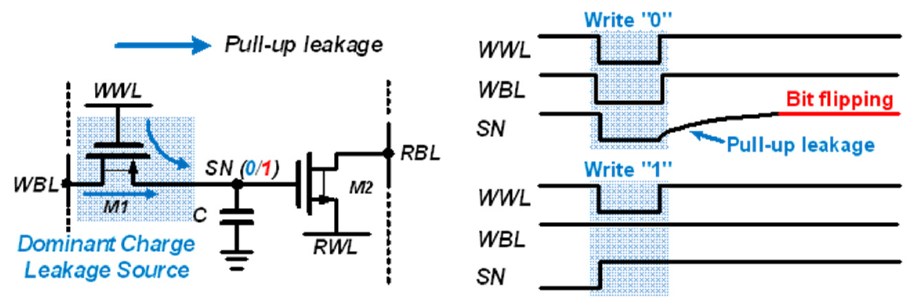
Figure 3. Schematic of conventional 2T1C gain cell.